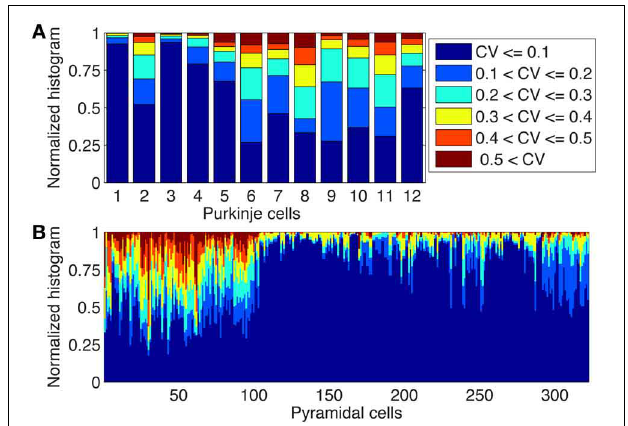
FIGURE 5 | Large changes in diameters of unbranched dendritic segments exist in Purkinje and Pyramidal neurons. Stacked histograms show the distribution of CV values for the diameters changes over unbranched dendritic segments in Purkinje cells ( A , N = 12) and in neocortical and hippocampal pyramidal neurons ( B , N = 322). Notice the presence of large variability of diameters (CVs > 0.2 or more) in many neurons and the large neuron to neuron differences which are mostly caused by lab to lab differences in reconstruction quality (see